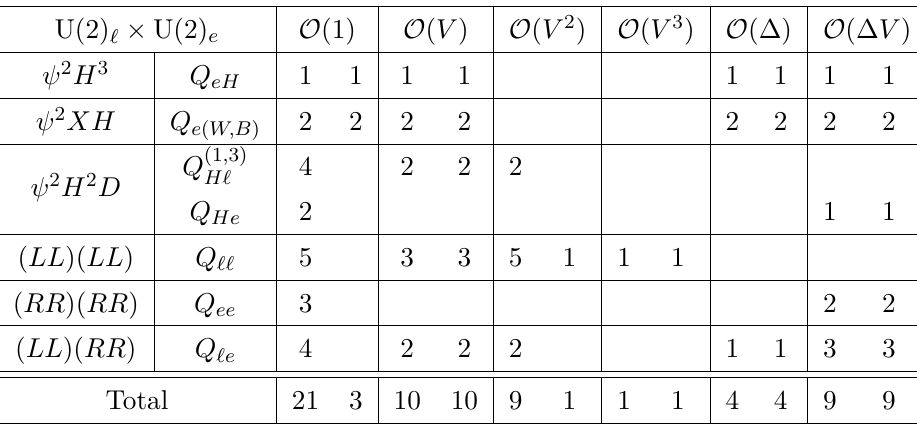
Table 10 . Counting of the pure lepton SMEFT operators (see appendix A) assuming U(2) ‘ × U(2) e symmetry in the lepton sector. Analogously to the counting performed in the quark sector assuming the same symmetry (see table 2), we once again take up to three insertions of V ‘ spurion, one insertion of ∆ e and one insertion of the ∆ e V ‘ spurion product. The left (right) entry in each column gives the number of CP even (odd) coefficients at the given order in spurion